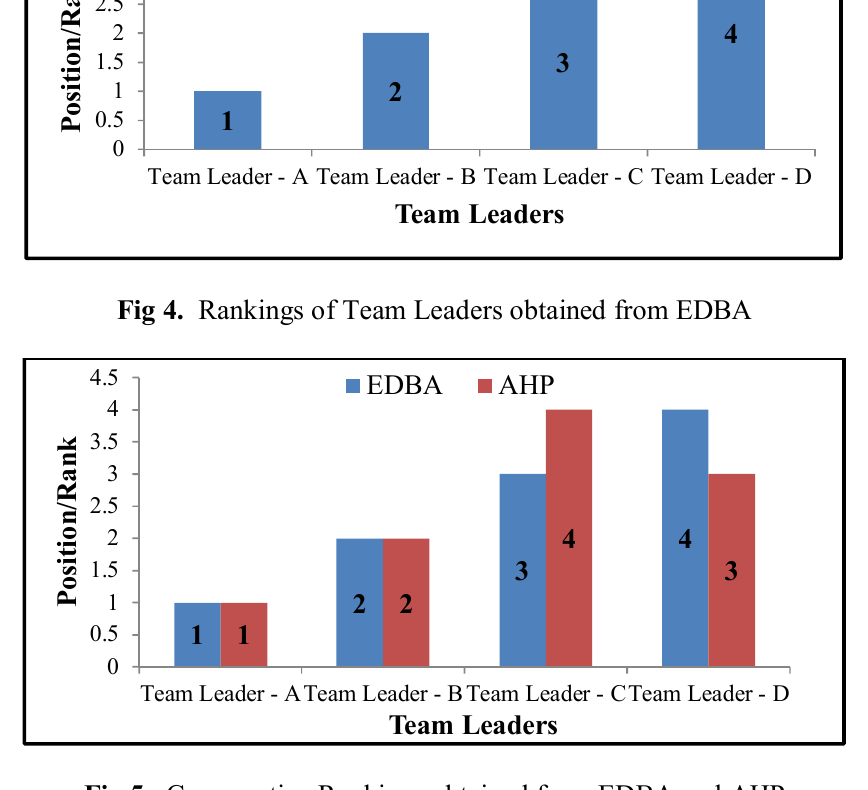
Fig 5. Comparative Rankings obtained from EDBA and